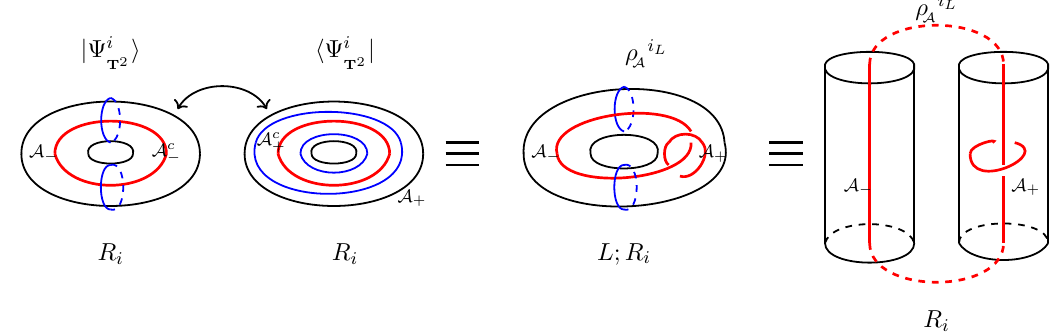
Figure 21 . Density matrix and R(cid:19)enyi entropy for the bipartitioning of the state j (cid:9) i A and A c split the T 2 into two-connected cylinders, and have a two-component entangling surface. We have constructed the density matrix by gluing the complement region A c M (cid:7) used to build the state and its conjugate, and found a convenient representation for it. The T 2 i L can be obtained by performing the Chern-Simons path integral over a solid density matrix (cid:26) A torus with a Wilson line placed along a link L in it. The boundary of the solid torus is given by the union of the complementary regions A (cid:0) and A + .